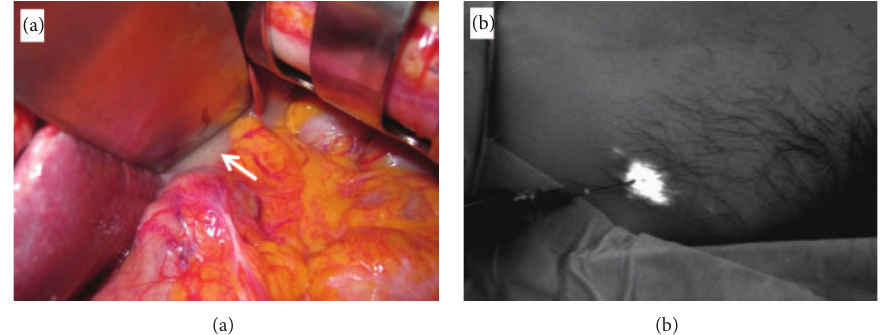
Figure 1: (a) The cisterna chili in the retroabdominal space below the diaphragm. (b) Indocyanine green is bilaterally injected subcutaneously into the inguinal region.